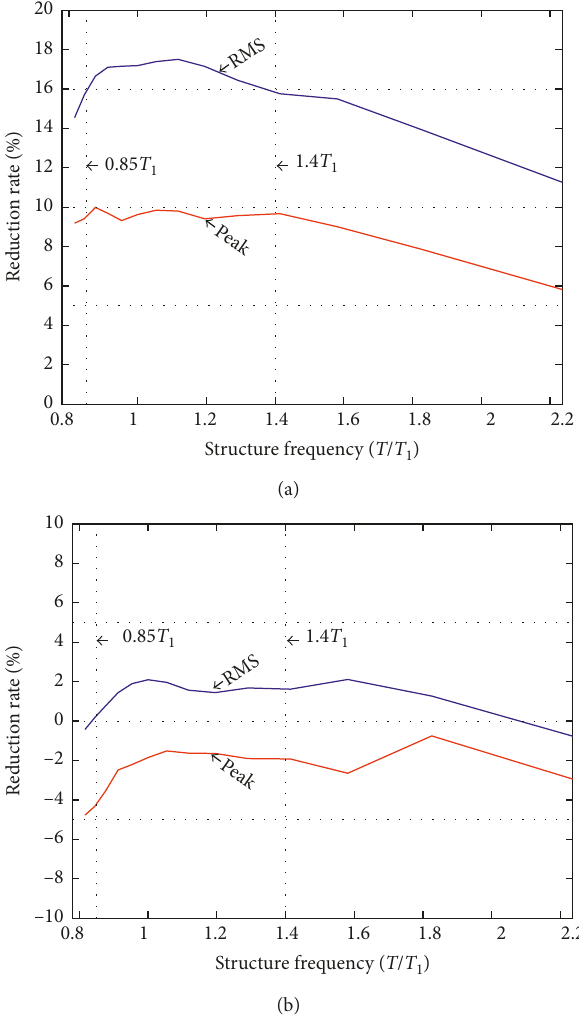
Figure 21: Reduction rates of (a) displacement and (b) acceleration with variation in structural